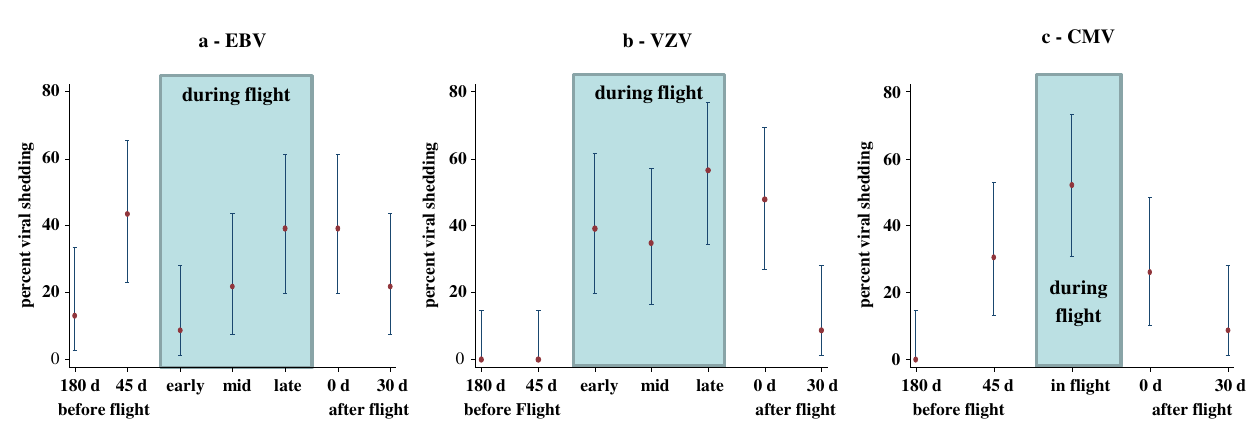
Fig. 1 Binomial 95% con fi dence intervals for percentage of crewmembers shedding virus, a : EBV, b : VZV, c :